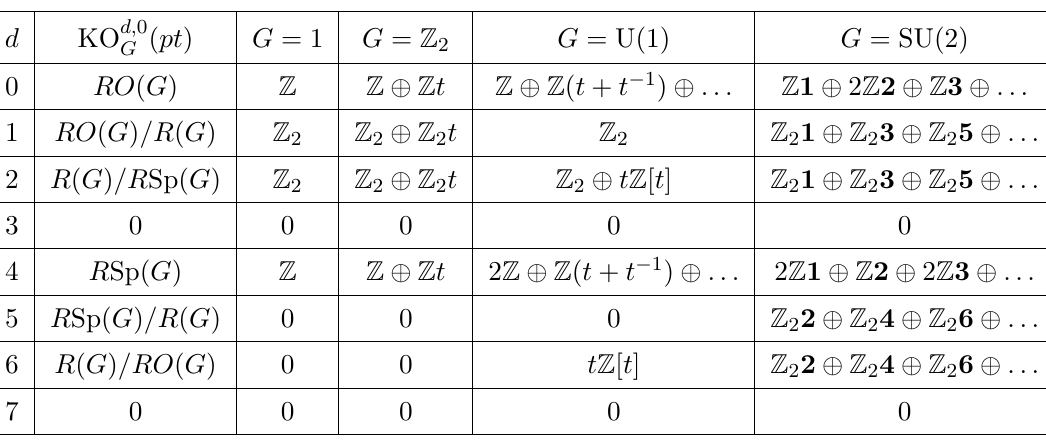
Table 3 . Coefficient ring of G -equivariant KO -theory and some